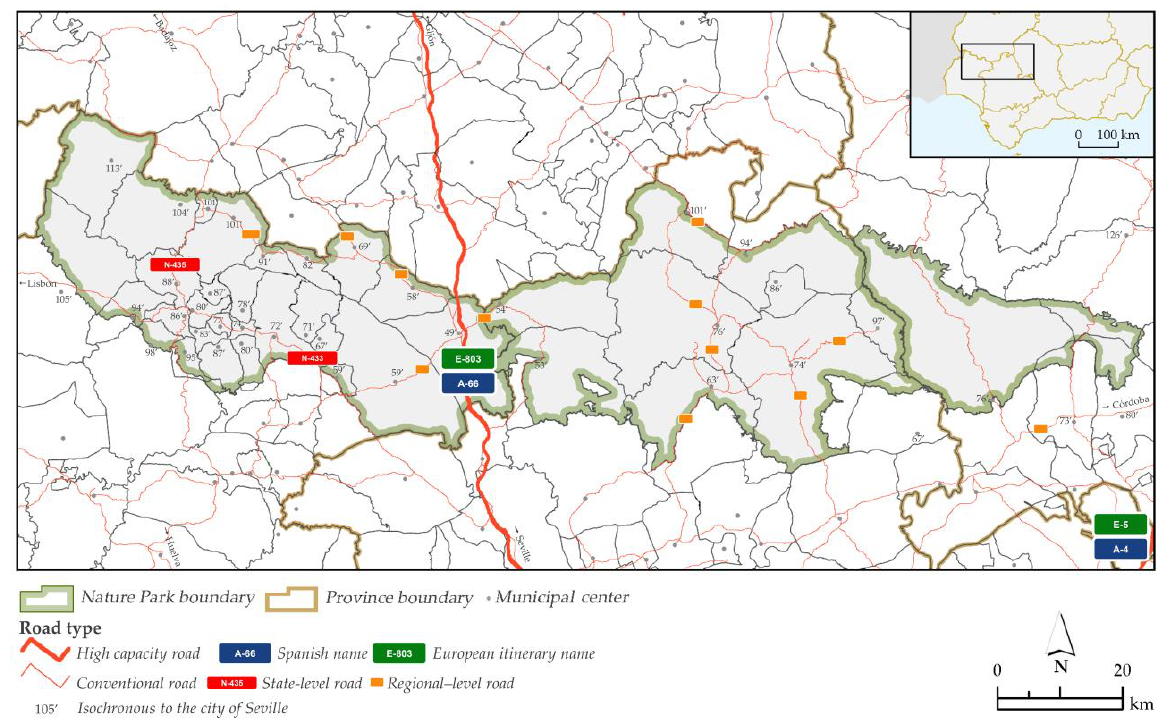
Figure 3. The communications network of the study area. Source: authors ’